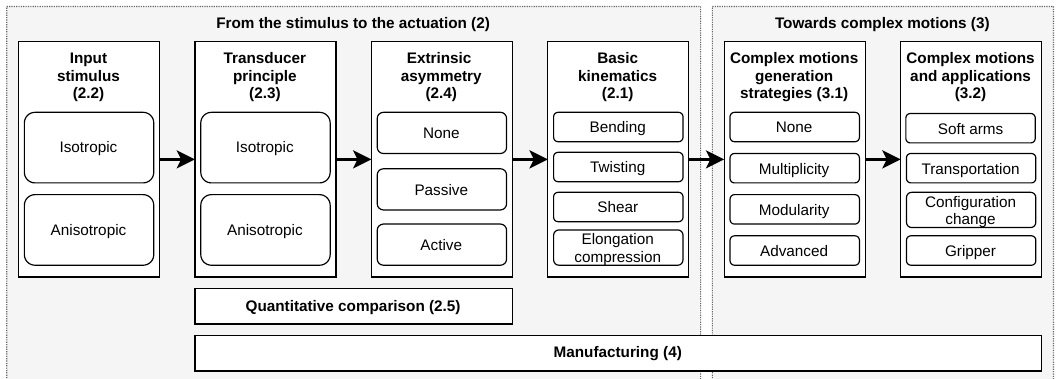
Figure 1. Schematic overview of this review corresponding to the proposed framework towards the mechanical programming of stimuli-responsive soft robots capable of complex motions: the numbers in brackets refer to the dedicated section.